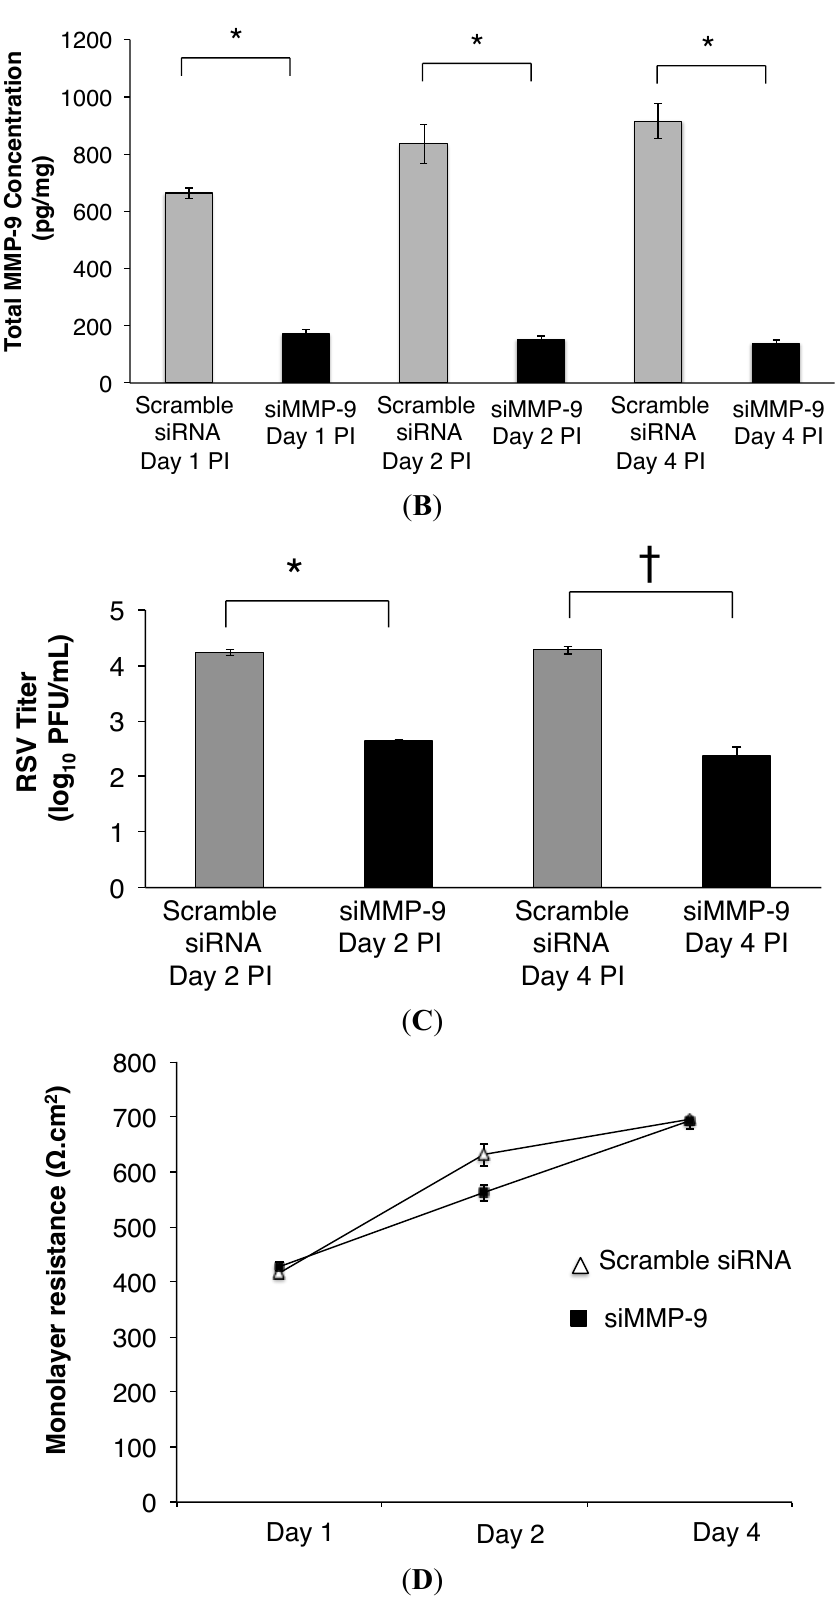
Figure 2. ( A ) MMP-9 knockdown in 16HBE cells using siRNA. RSV infection (MOI = 1) was performed 24 h post transfection with siRNA (s8864 at 10 µL; Ambion) against MMP-9. Transient transfection of siRNA s8864 resulted in knockdown of MMP-9 by 60%–80% on day1–4 PI. In contrast, cells transfected with scramble siRNA had